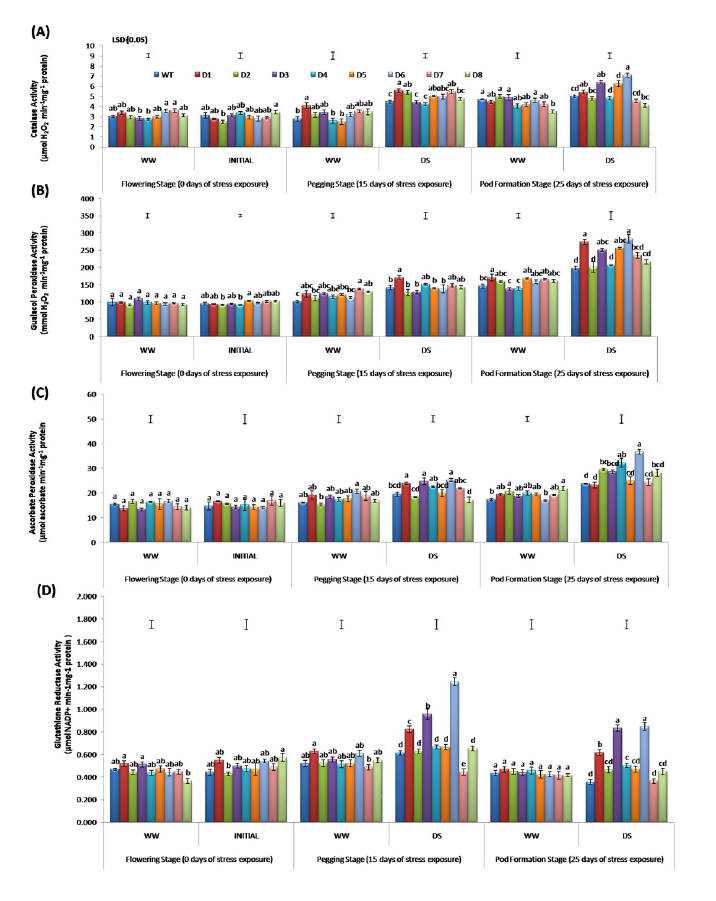
Fig 4. Comparison of various antioxidant enzymatic activities including (A) Catalase, (B) Guaiacol peroxidase, (C) Ascorbate peroxidase and (D) Glutathione reductase in WT and T lines at 0, 15 and 25 days after stress imposition.